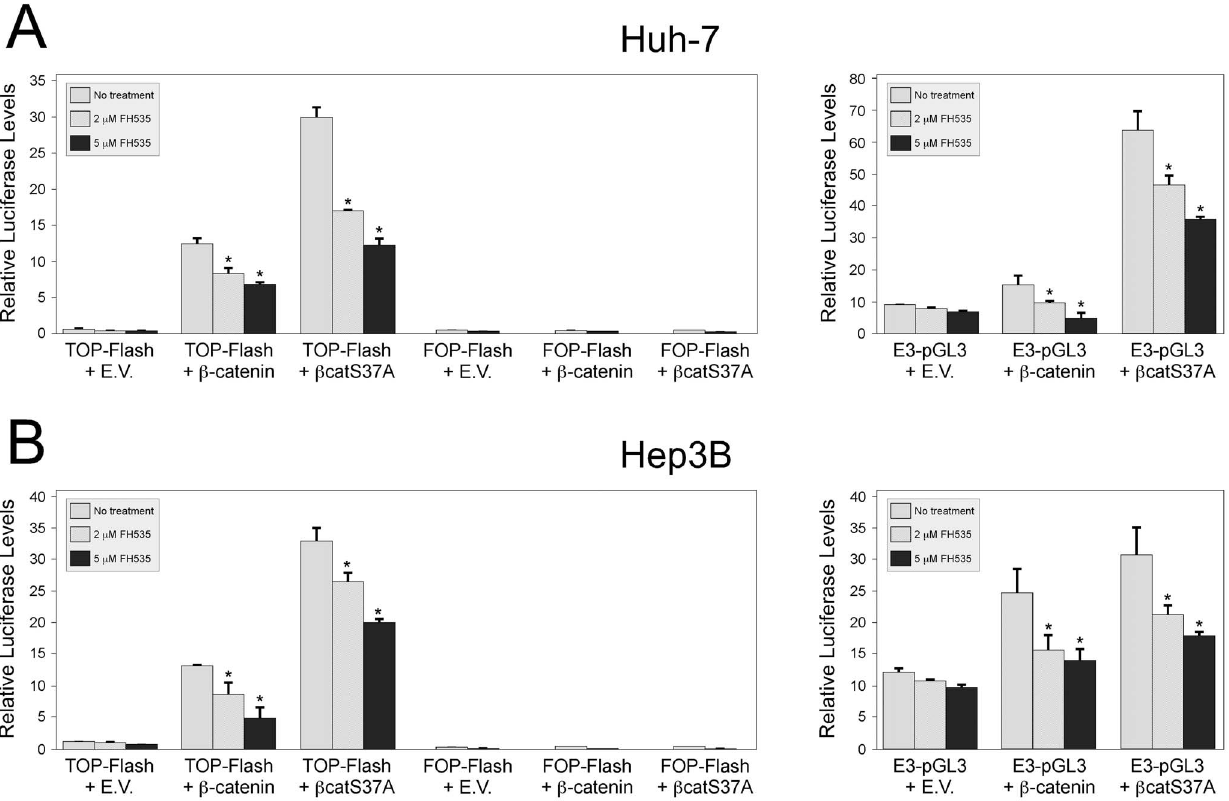
Figure 1. FH535 inhibits b -catenin dependent transcriptional activation in HCC cell lines. Huh7 (Panel A) and Hep3B (Panel B) HCC cells were transfected with the luciferase reporter genes TOPFlash (left panels), which contains three TCF binding sites, or E3-pGL3 (right panels), which contains the AFP enhancer element E3 that has a highly conserved TCF site. Cells were additionally co-transfected with an expression vector that contained no insert (empty vector control, E.V.), wild-type b -catenin ( b -catenin), or a constitutively active form of b -catenin ( b catS37A). Renilla luciferase was used to control for variations in transfection efficiency. Six hours after the addition of DNA, cells were treated with DMSO alone (no treatment) or increasing amounts of FH535. After 48 hours, luciferase levels were determined; firefly luciferase was normalized to renilla. In both cell lines, FH535 inhibited b -catenin-dependent activation of target genes. * P , 0.05. The experiment was done twice with similar results.